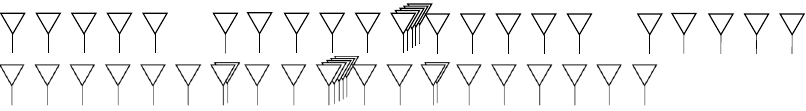
Figure 11. Non-redundant array with an interval of (1,3,5,2) can make a 23-sized VAA ( up ) and the MRA with an interval of (1,3,3,2) can make a 19-sized VAA ( down ).